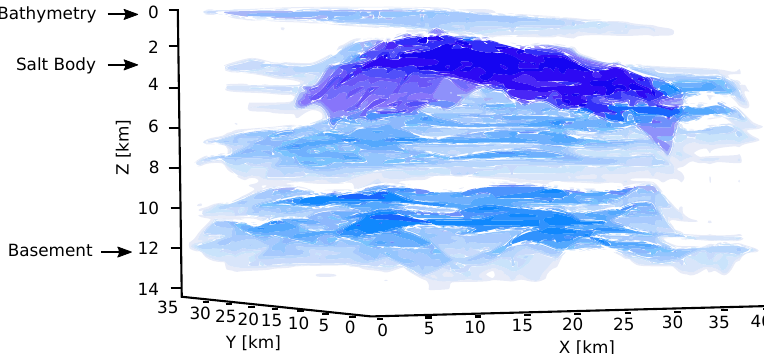
Figure 7. Interpolated geological horizons from previously interpreted seismic